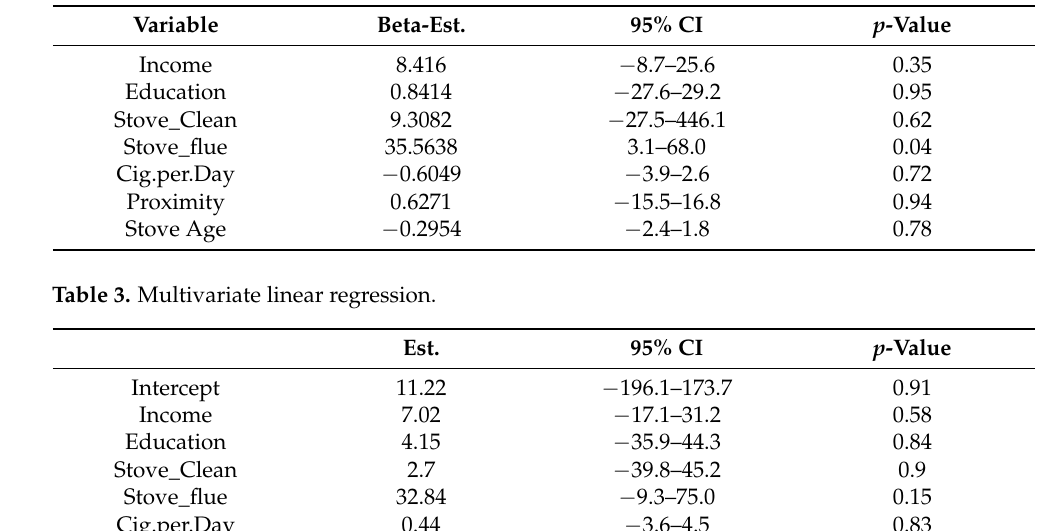
Table 2. Univariate linear regression.